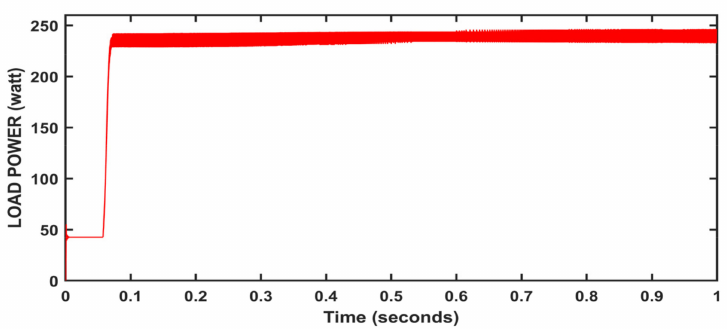
Figure 28. Output power of NN system at constant irradiance, temperature, and load.